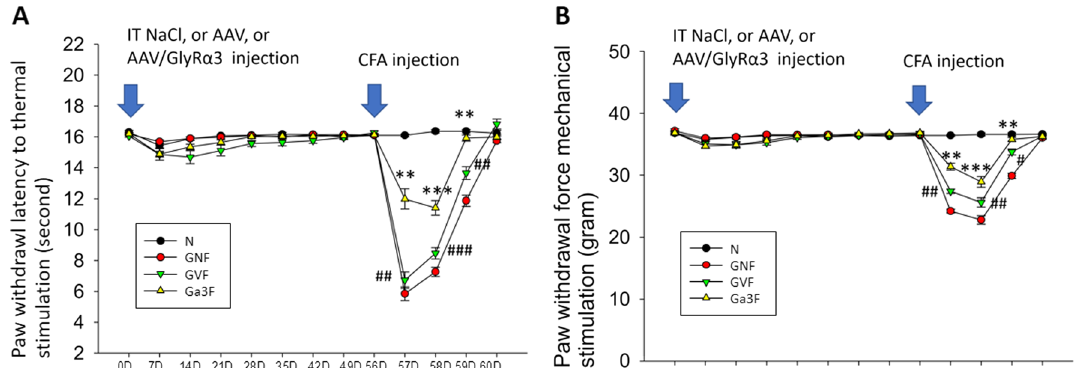
Fig. 4 Behavioral responses to thermal and mechanical stimuli on hind paws. The hind paw withdrawal response to A thermal hyperalgesia and B mechanical allodynia was assessed at day 0 (baseline); weekly for two months after intrathecal injection of AAV‑GlyRα3 (2.5 AAV (2.5